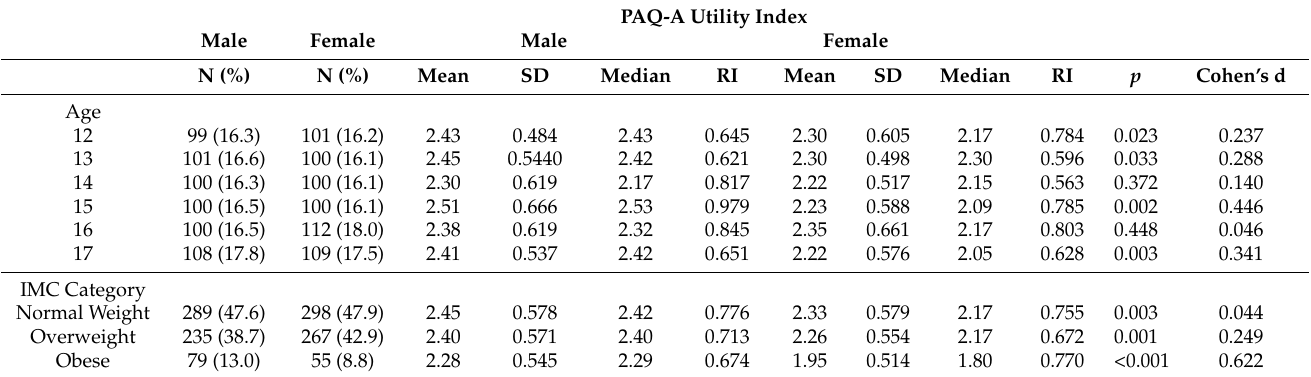
Table 2. PAQ-A population normative values by gender, age and BMI categories. PAQ-A Utility Index Male